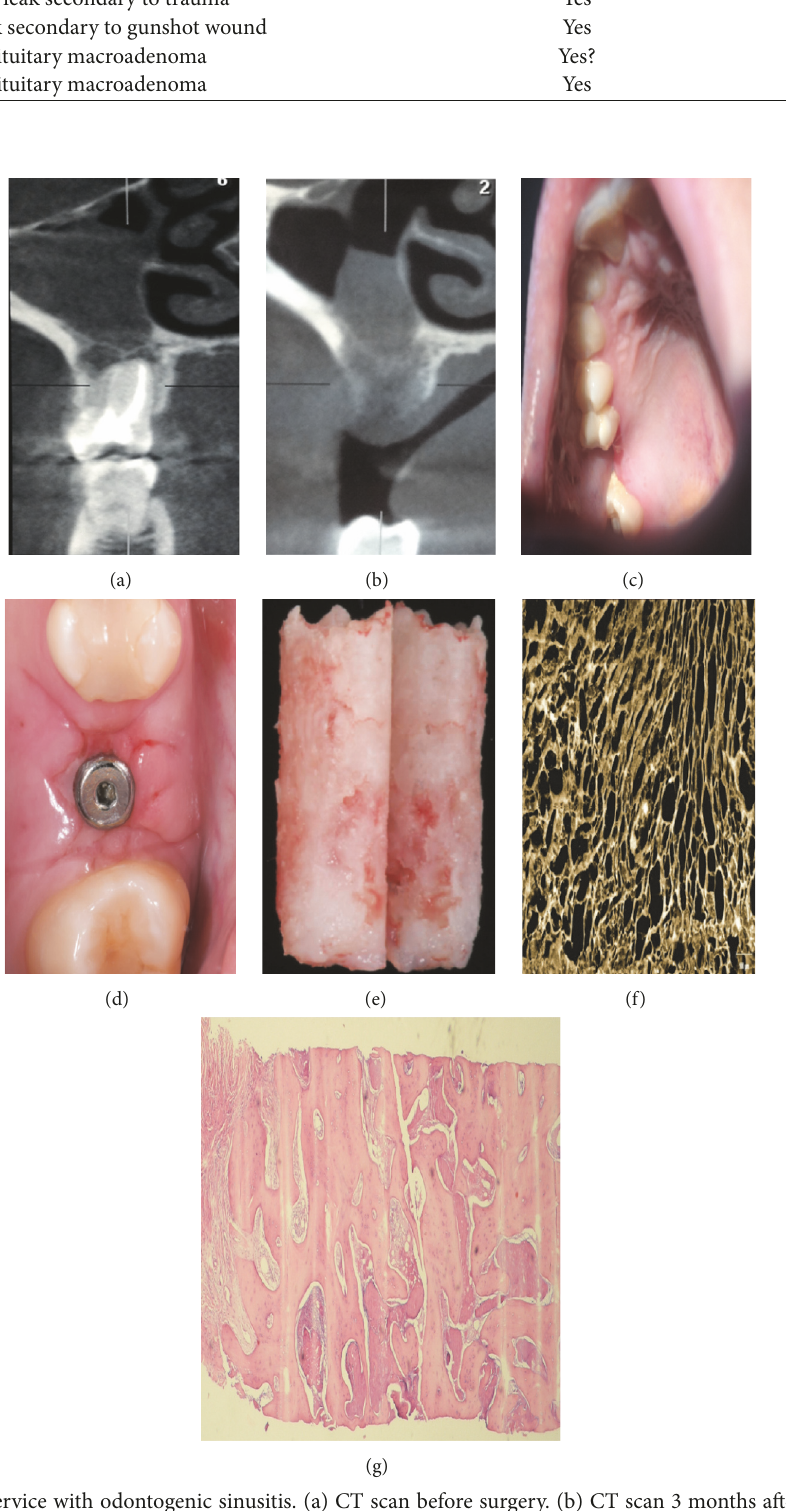
Figure 3: Patient of our service with odontogenic sinusitis. (a) CT scan before surgery. (b) CT scan 3 months after surgery. (c) Aspect of the mouth before the implant. (d) Implant site. (e) Biopsy of bone at the implant site. (f) Confocal microscopy of the bone recollected at the implant site. (g) Hematoxylin and eosin staining showing the presence of normal